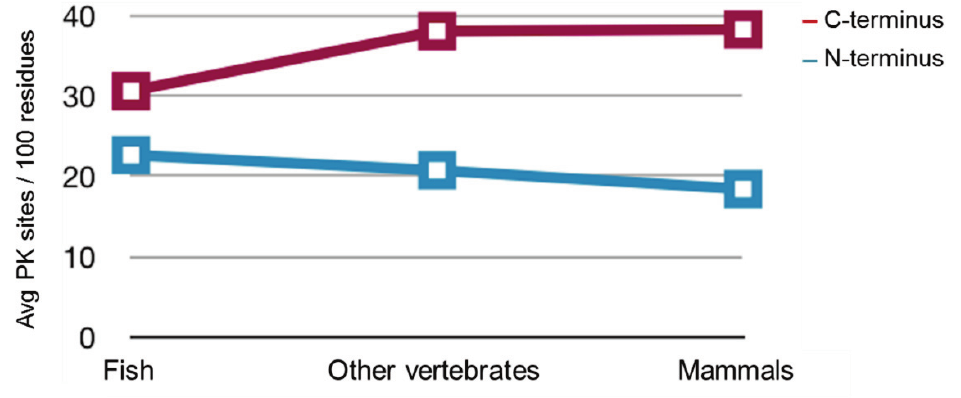
Figure 8. Comparison of normalized PK target sites in vertebrate taxa and PrP domains. Mean values of normalized PK target sites (average values of sites/100 residues — see Methods) across the three different vertebrate taxa that were examined, namely fish, other vertebrates (excluding fish or mammals) and mammals. The N -terminal region of PrPs is marked in blue, while the C -terminal region is marked in red. It is evident that the only statistically significant difference in these measurements arises from the lower value of the fish C -terminal region (see Text for details).